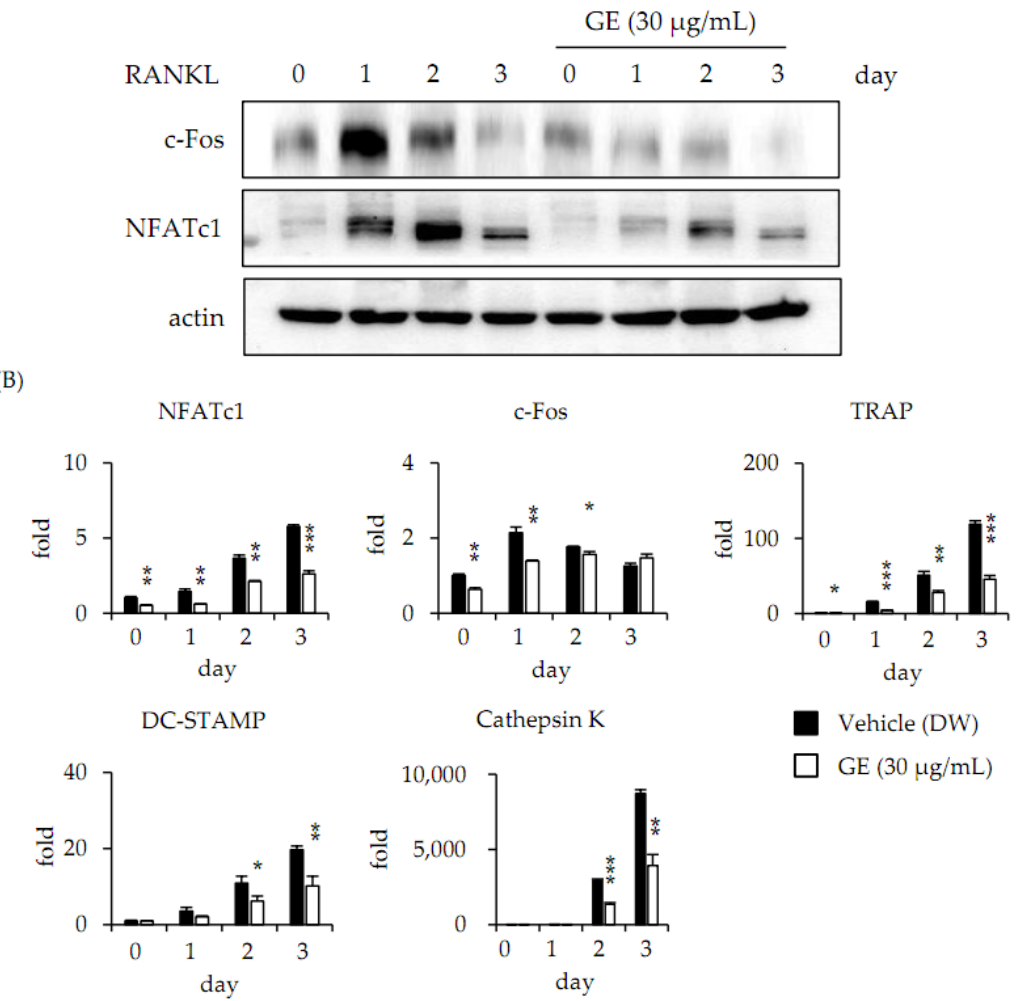
Figure 2. GE inhibits RANKL-induced expression of NFATc1. ( A ) BMMs were pretreated with vehicle (0.1% DW) or GE (30 µ g/mL) for 1 h prior to RANKL (10 ng/mL) and M-CSF (30 ng/mL) stimulation at the indicated times. Cell lysates were resolved by sodium dodecyl sulfate-polyacrylamide gel (SDS-PAGE), and Western blotting was performed with anti-c-Fos, anti-NFATc1, and anti-actin antibodies as indicated; ( B ) BMMs were treated with a vehicle (0.1% DW) or GE (30 µ g/mL) for 1 h, and RANKL (10 ng/mL) and M-CSF (30 ng/mL) were then treated at the indicated times. Total